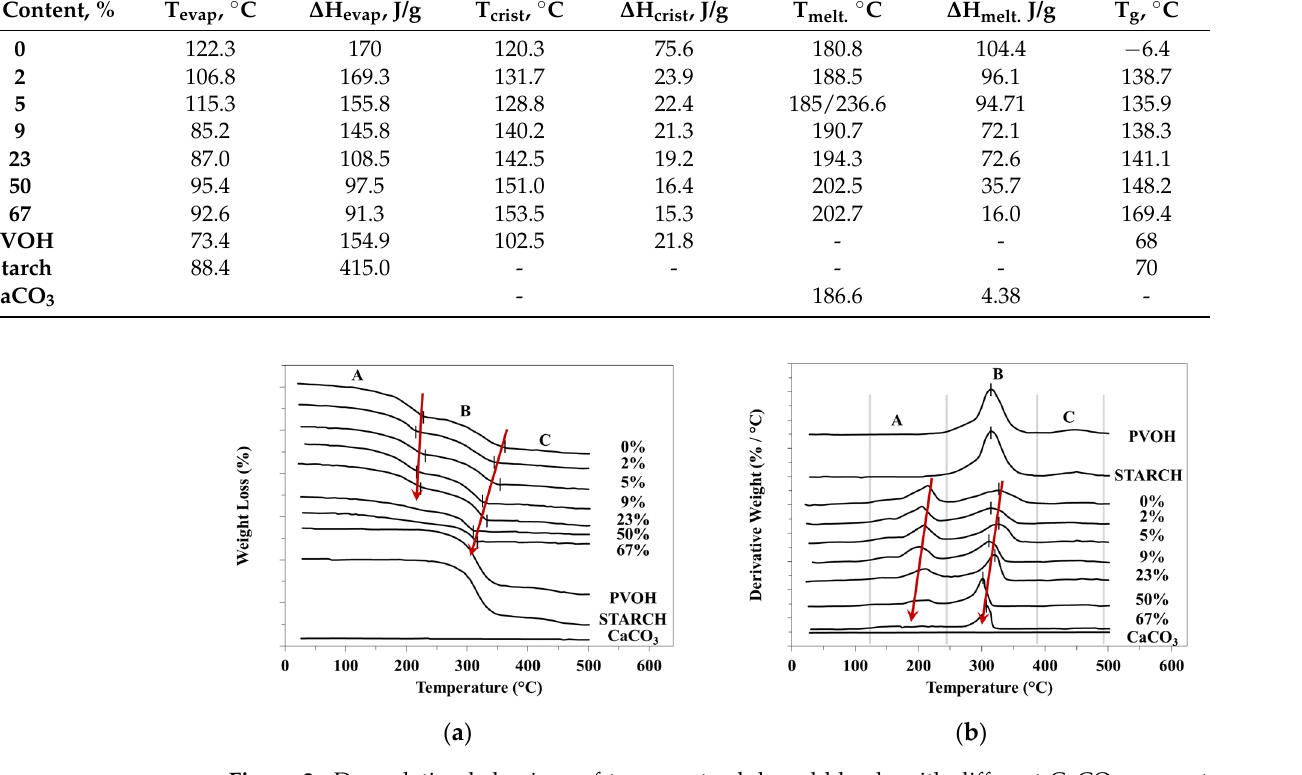
Table 6. Thermal behaviour of compounds with and without wood flour and the same CaCO 3 amount.